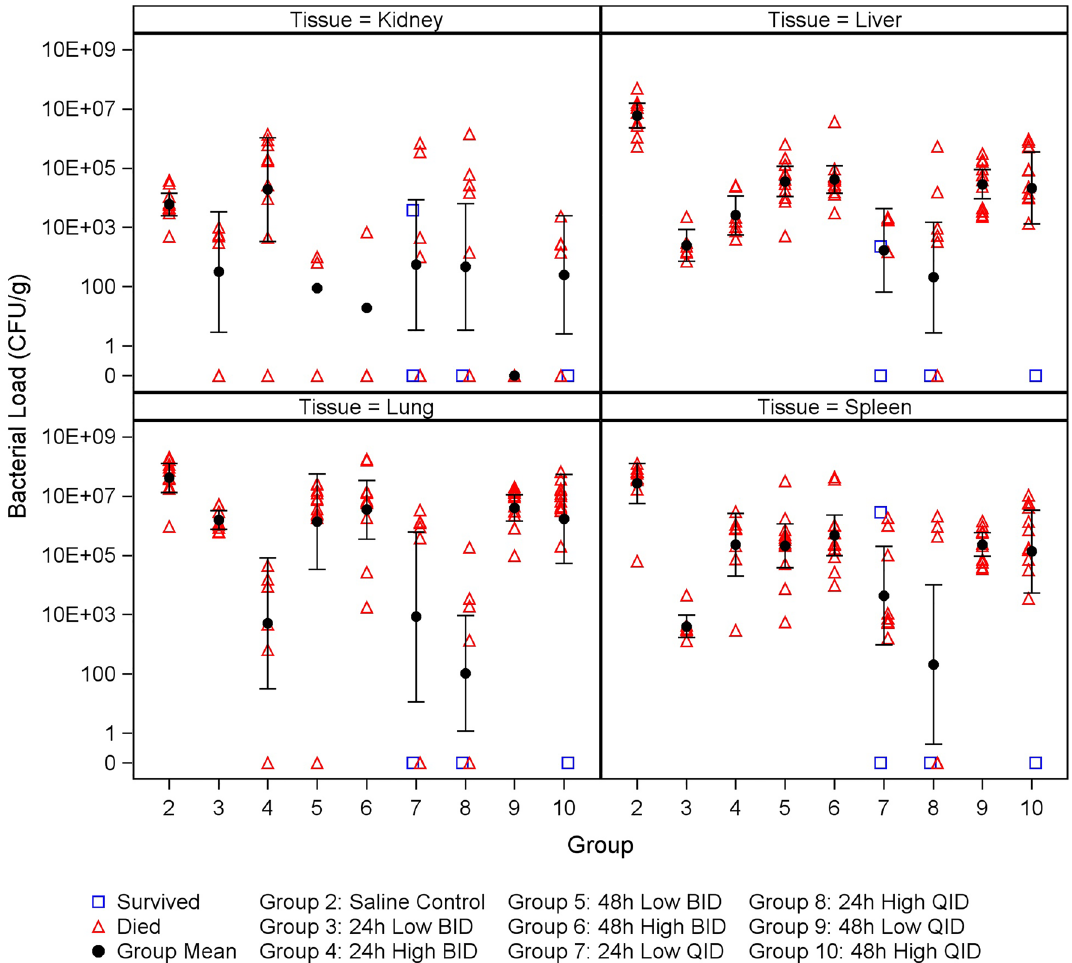
Figure 3. Observed bacterial load data (CFU/g) with mean and 95% confidence interval by group. Individual, mean, and 95% confidence intervals of CFU/g in the kidney, liver, lung, and spleen of infected treated animals. Specimens were collected at the time of termination or death. The mean bacterial load of the 48 h Low QID group, in which all measurements were negative, was significantly less than that of the saline group (p = 0.0127). The mean bacterial loads of all treated groups were significantly less than that of the saline group for the liver (p values ranged from < 0.0001 to 0.0024). The mean bacterial loads of the 24 h QID groups were significantly less than that of the saline group for the lung and spleen (p ≤ 0.0001). Furthermore, the mean bacterial load of the 24 h High BID group was significantly less than that of the saline group for the lung (p = 0.0001), and